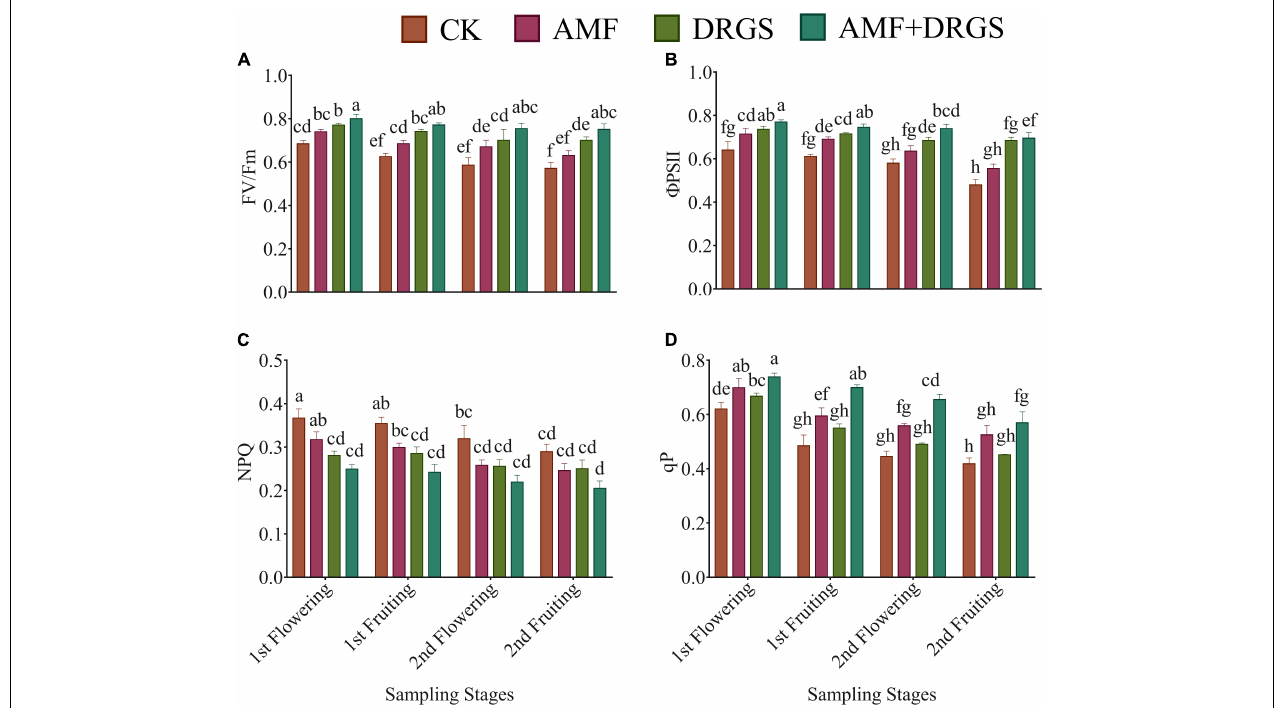
FIGURE 4 | Effect of AMF inoculation and DRGS on maximal (A) photochemical efficiency ( F v / F m ), (B) chlorophyll photosystem II ( (cid:56) PSII), (C) non-photochemical quenching coefficient (NPQ), (D) photochemical quenching (qP) on eggplant leaves at 1st flowering, 1st fruiting, 2nd flowering, and 2nd fruiting stages. Data represent the means of ± S.E. ( n = 5). Different letters show significant differences within treatments. Tukey’s HSD test was employed to verify statistical significance at p <